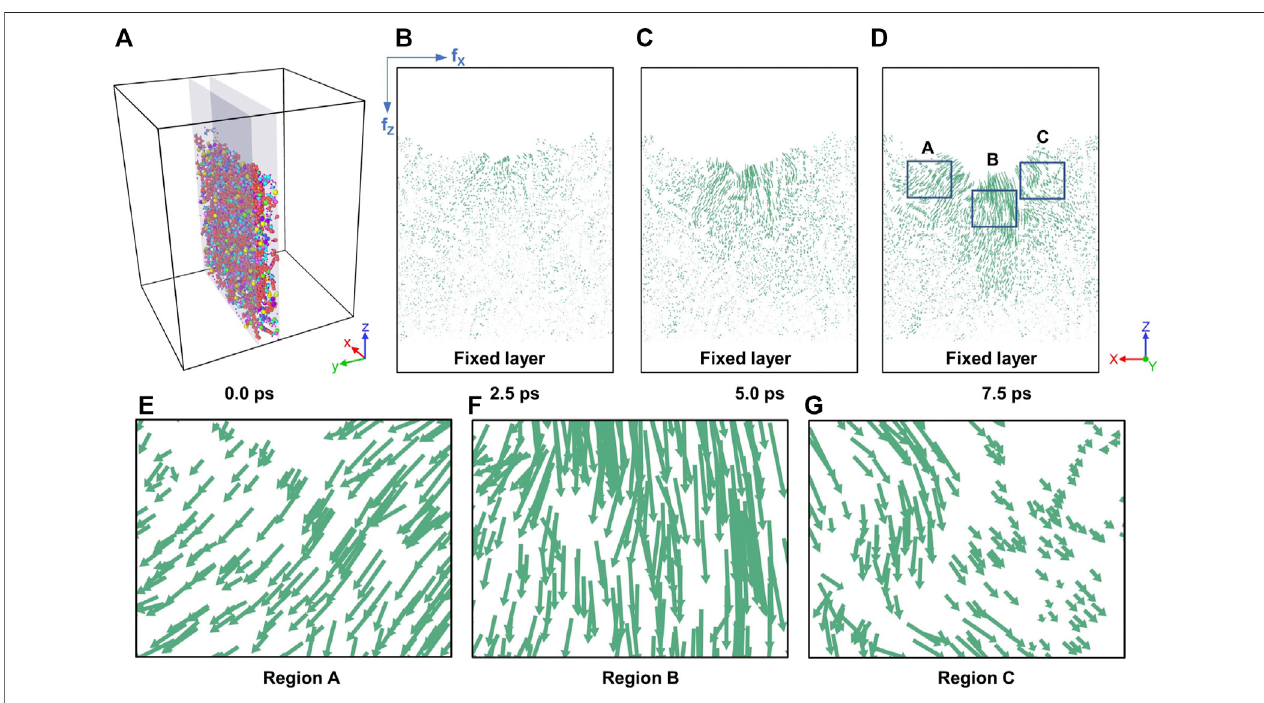
FIGURE 4 | (A) The selected 10 Å vitrinite slice prior to nanoindentation. Displacement vectors of atoms in the 10 Å vitrinite slice during nanoindentation at (B) 2.5 ps, (C) 5.0 ps, and (D) 7.5 ps. Zoomed-in view of the distributions of displacement vectors at regions (E) A, (F) B, and (G) C at 7.5 ps as marked in (D) .